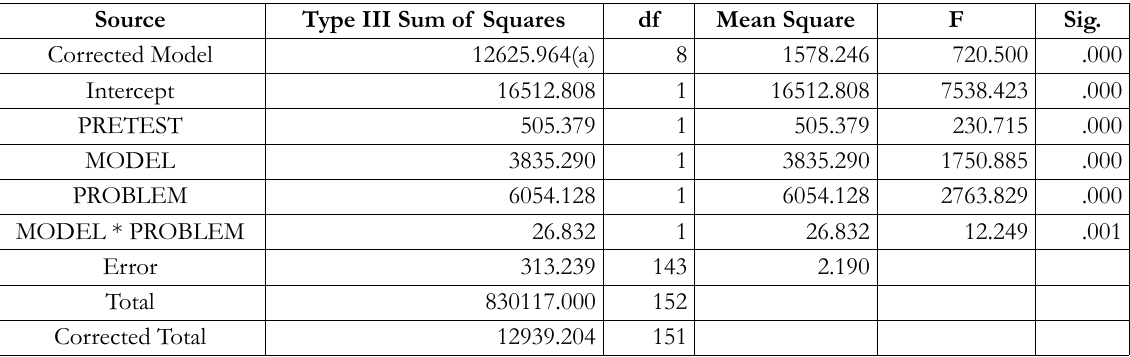
Table 4. The Result of Two-way Anacova test for the Posttest of Problem Solving